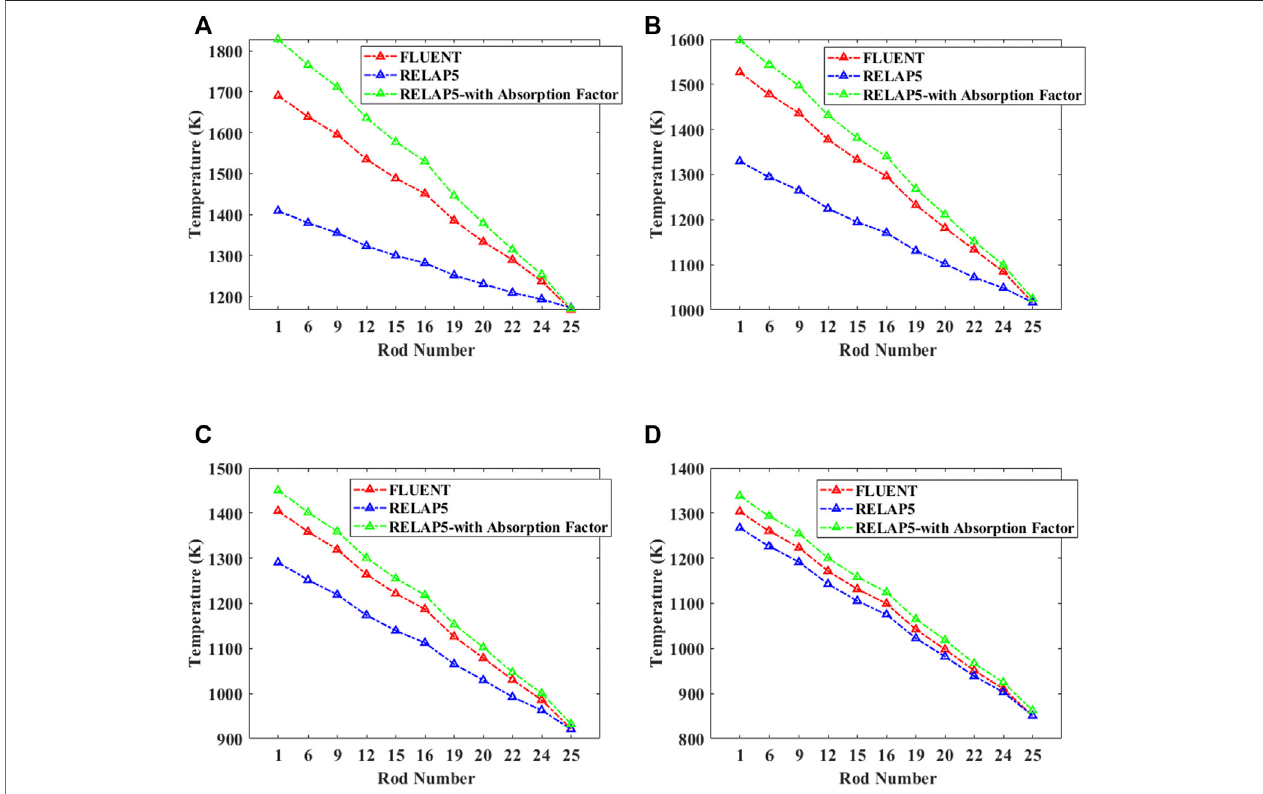
FIGURE 11 | Temperature results for p/d = 1.3: (A) emissivity = 0.3, (B) emissivity = 0.5, (C) emissivity = 0.7, and (D) emissivity = 0.9.